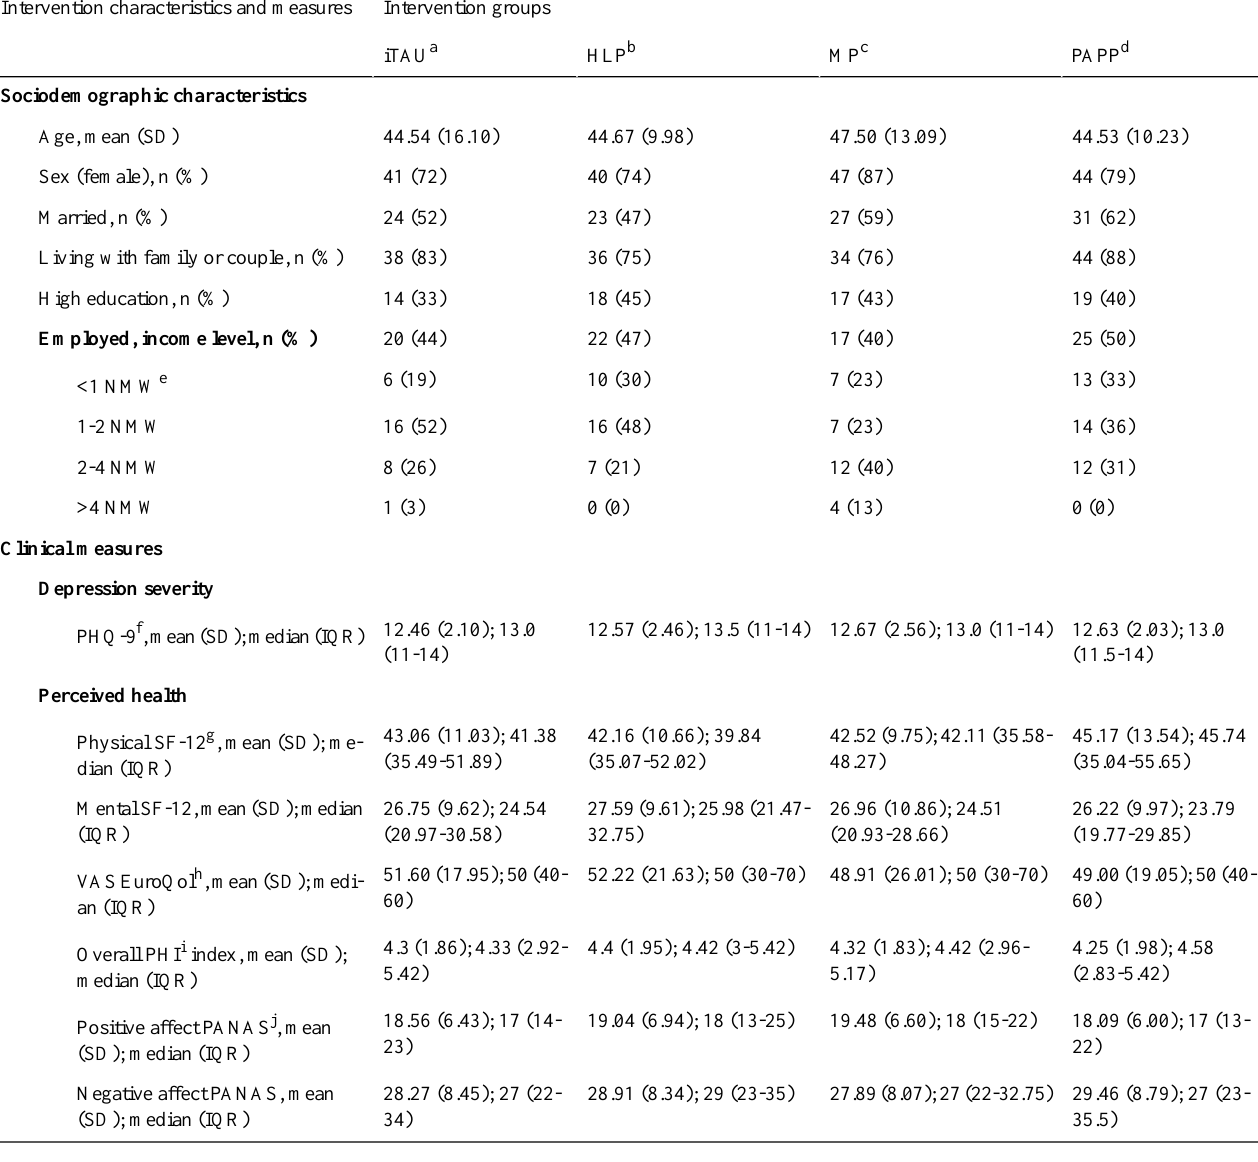
Intervention groupsIntervention characteristics and